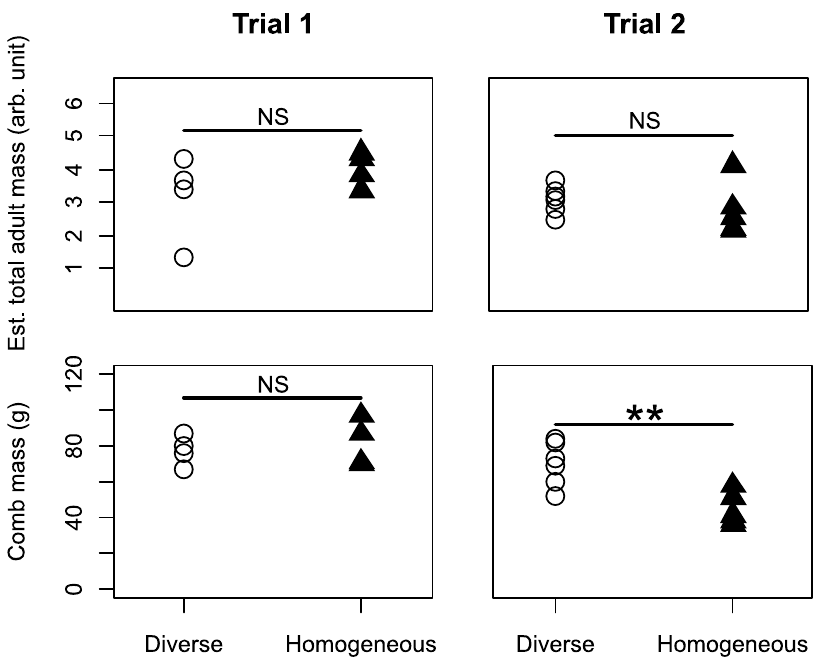
Figure 2. Colony performance measures as a function of worker body size distribution. Results shown for diverse or homogeneous colonies, separately for Trial 1. (left column) and Trial 2 (right column). Upper row: the total mass of adults produced over the course of the experiment per colony.